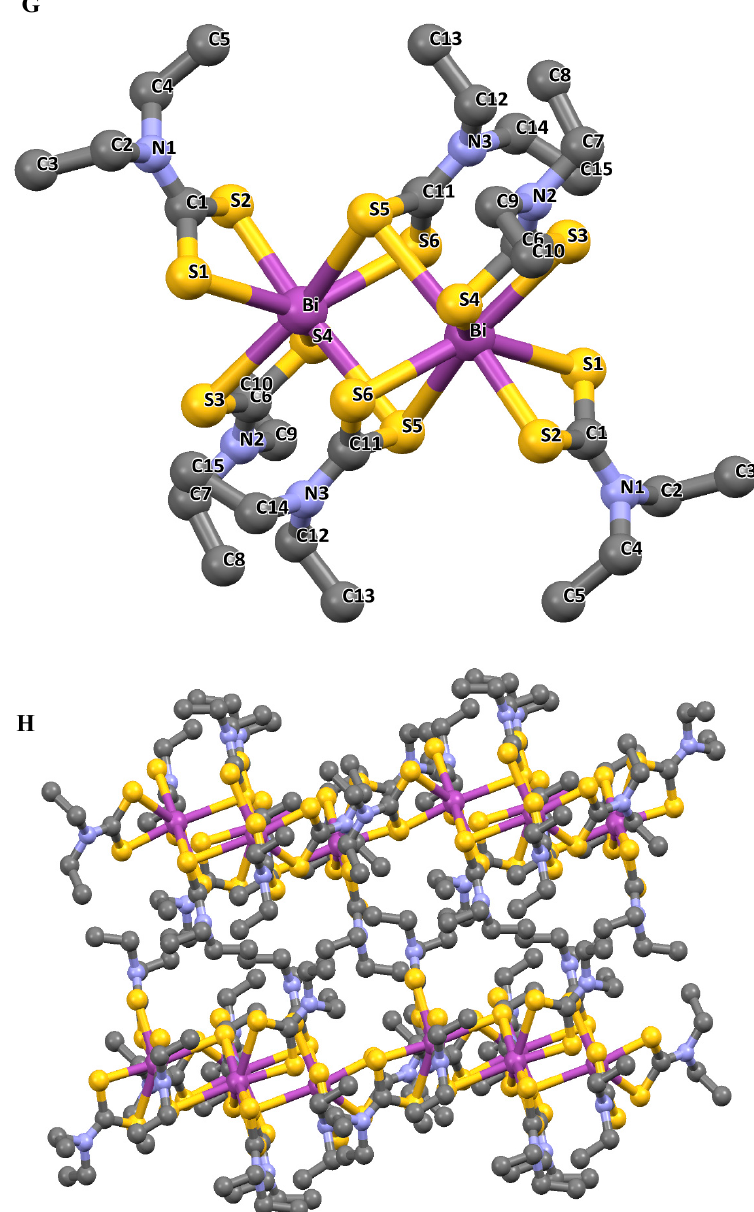
Figure 4. ( A ) Crystal structure and the labelling scheme of [SbCl(Me 2 DTC) 2 ]n (1a). ( B ) Intermolecular, ···· Sb interactions leading to polymerisation of [SbCl(Me µ 2 —S and the labelling scheme of [SbCl(Me 2 DTC) 2 ]n (1b). ( D ) Intermolecular µ 2 —S ···· Sb